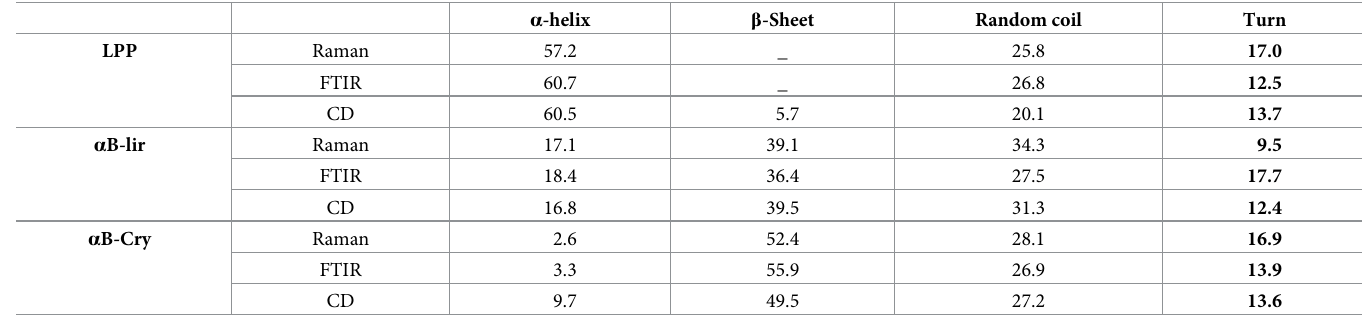
Table 1. The protein secondary structure elements (%) of LPP, α B-lir and α B-Cry obtained by three different methods as Raman, ATR-FTIR and far UV-CD. α -helix β -Sheet Random coil Turn LPP Raman